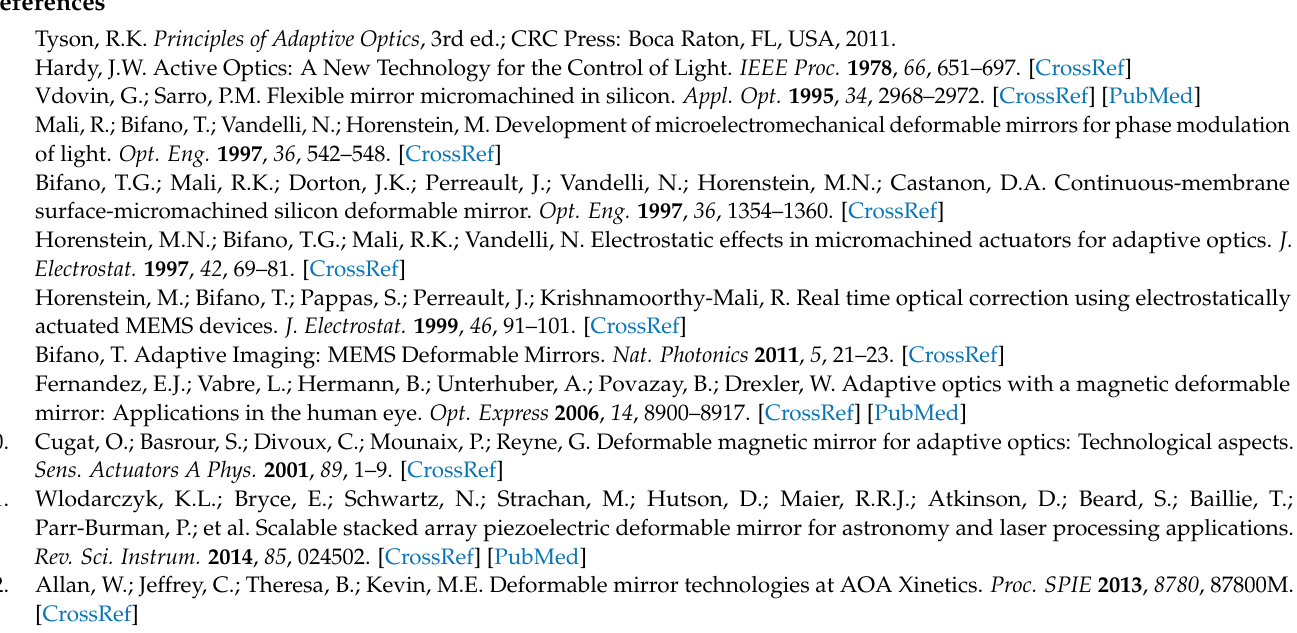
Figure S3: Microscope photographs of copper coil and magnet used for electromagnetic